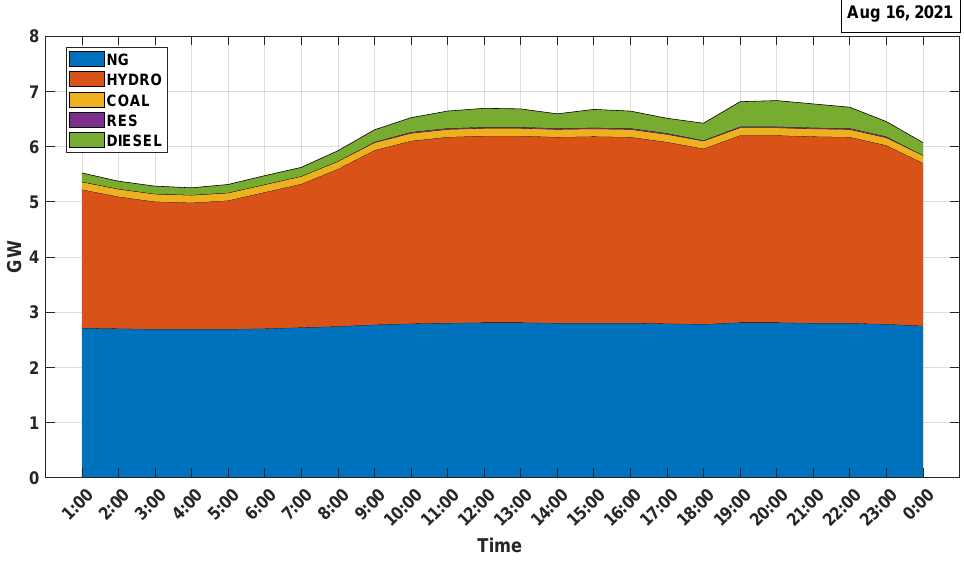
Figure 19. Contribution to the dispatch of the electrical system—stage 3.